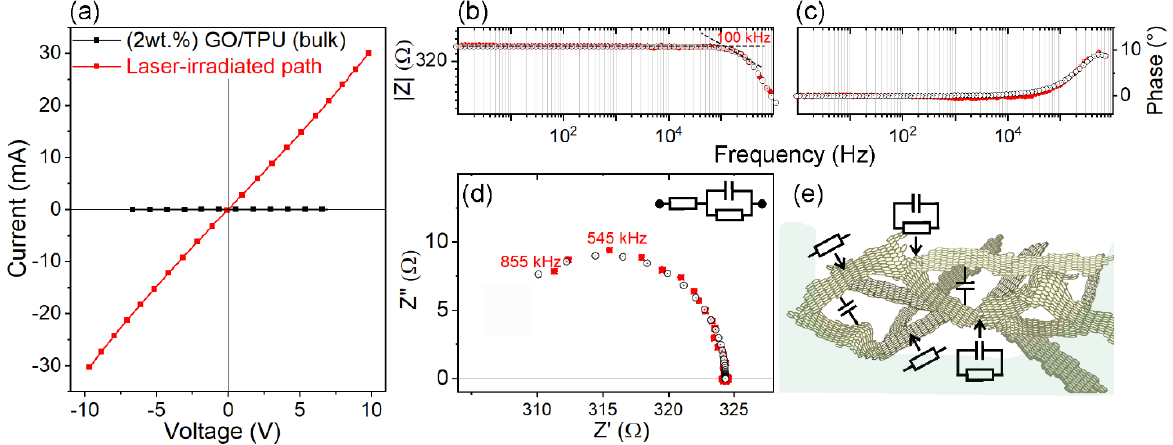
Figure 7. DC and AC electrical properties of a 60 mm conductive laser ‐ irradiated path as obtained by four ‐ probe measurements (electrical measurements by four 10 mm spaced electrodes): ( a ) I–V graph of the conductive track (red curve), as compared to GO/PU polymer composite leather (GO 2 wt.%) (black curve); ( b – d ) Bode magnitude and phase and Nyquist plots for the same conductive path (red points) in the 1 Hz–900 kHz frequency range, respectively. EIS ‐ fitted curves (B/N points) are shown for comparison in ( b – d ); ( e ) schematic representation describing capacitance (C) and resistance (R) elements of the RGO sheets in the conductive paths after laser irradiation according to frequency responses.